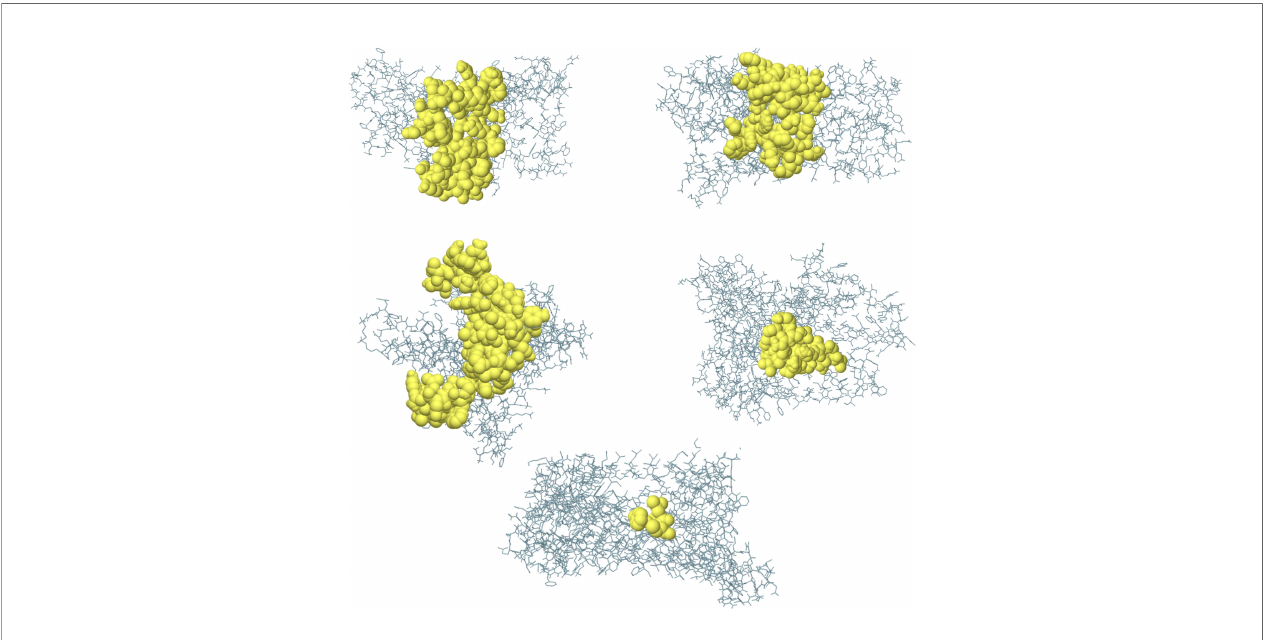
FIGURE 7 | Three-dimensional representation of conformational B cell epitopes of BFV. In A-G, the bulk of the polyprotein is represented in grey sticks, and the yellow surfaces represent the conformational B cell epitopes.